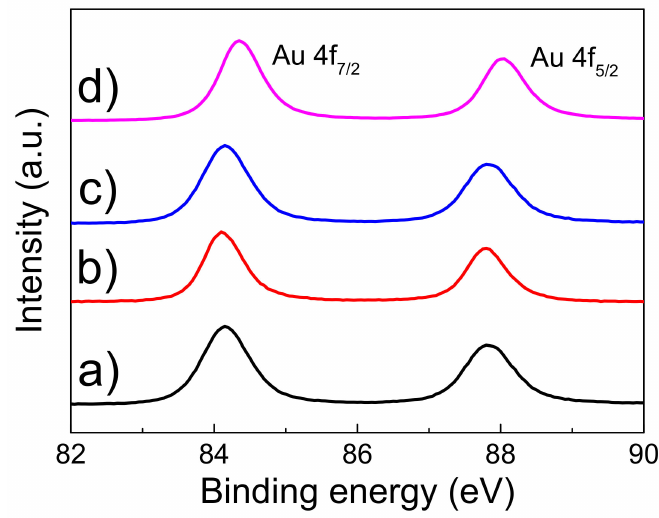
Figure 2. Au 4f XPS spectra of: ( a ) gold nano-porous; ( b ) 8 nm 300 ◦ C; ( c ) 17 nm 400 ◦ C; ( d ) laser dewetted at fluence of 0.5 J cm − 2 .